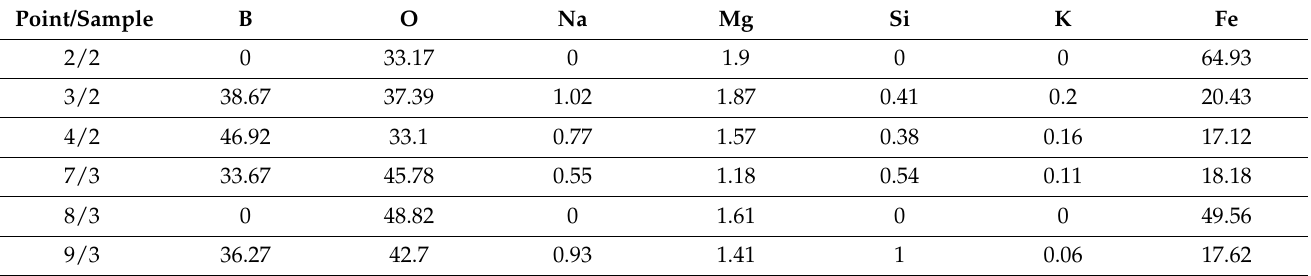
Figure 6. Secondary electron images (SEI) ( a , b ) and backscattered electron composition (BEC) ( c ) of the sample treated at 850 °C. Table 1. EDS semiquantitative elemental composition of the selected particles in Figures 5c and 6c correspond to Sample 2 (650 °C) and Sample 3 (850 °C), respectively.